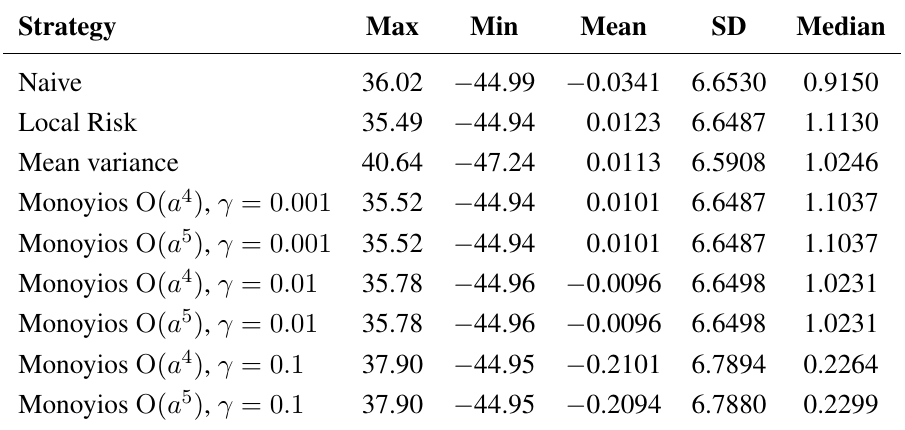
Table 2. Summary statistics of hedging error for the put option with parameters given by Table 1 and ρ = 0 . 85